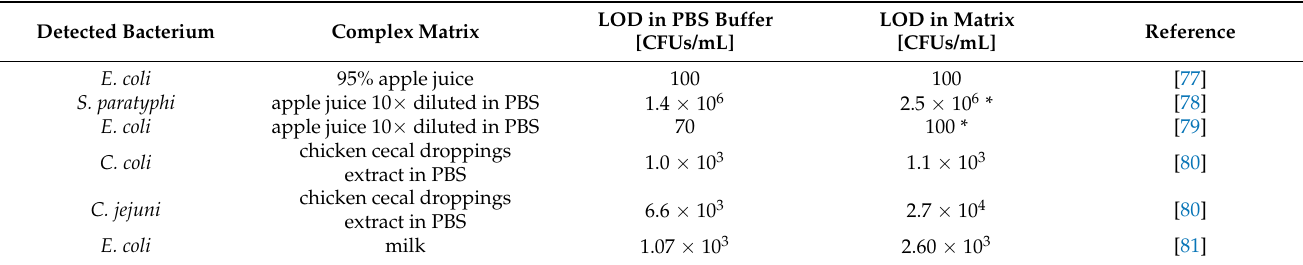
Table 5. Comparing different SIP-based bacteria